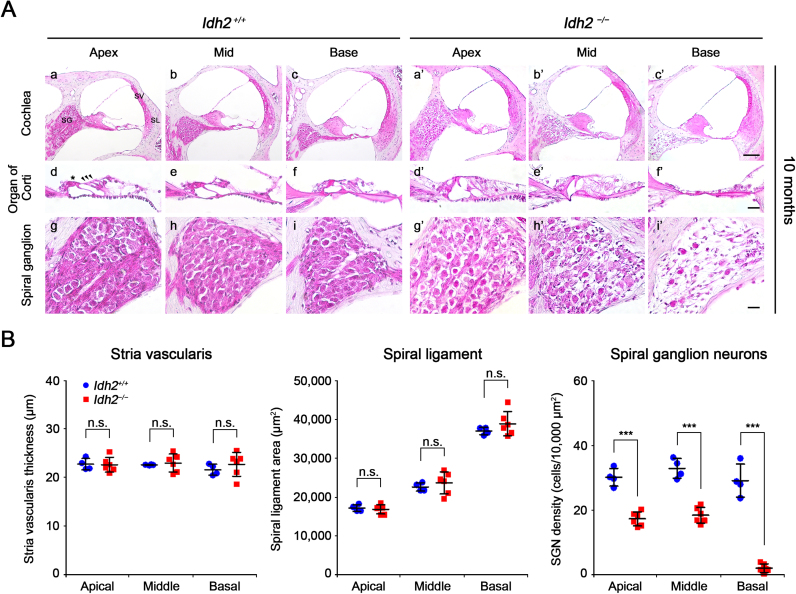
Histological evaluation of cochlea fromIdh2+/+andIdh2−/−mice. (A) H&E staining was performed in the inner ear sections of Idh2+/+ (n = 4) and Idh2−/− (n = 6) mice at 10 months of age. SG, spiral ganglion; SV, stria vascularis; SL, spiral ligament. Scale bars; 100 µm in (i′) and 20 µm in (c′ and f′). The arrowheads point to three rows of outer hair cells, and the asterisk (*) indicates an inner hair cell. (B) The thickness of the stria vascularis, the mean area of the spiral ligament, and the density of spiral ganglion neurons at apical, middle, and basal turns of cochlea were measured in the inner ear sections of Idh2+/+ (blue circles) and Idh2−/− (red squares) mice at 10 months of age. ***p < 0.001; n.s., nonsignificant.